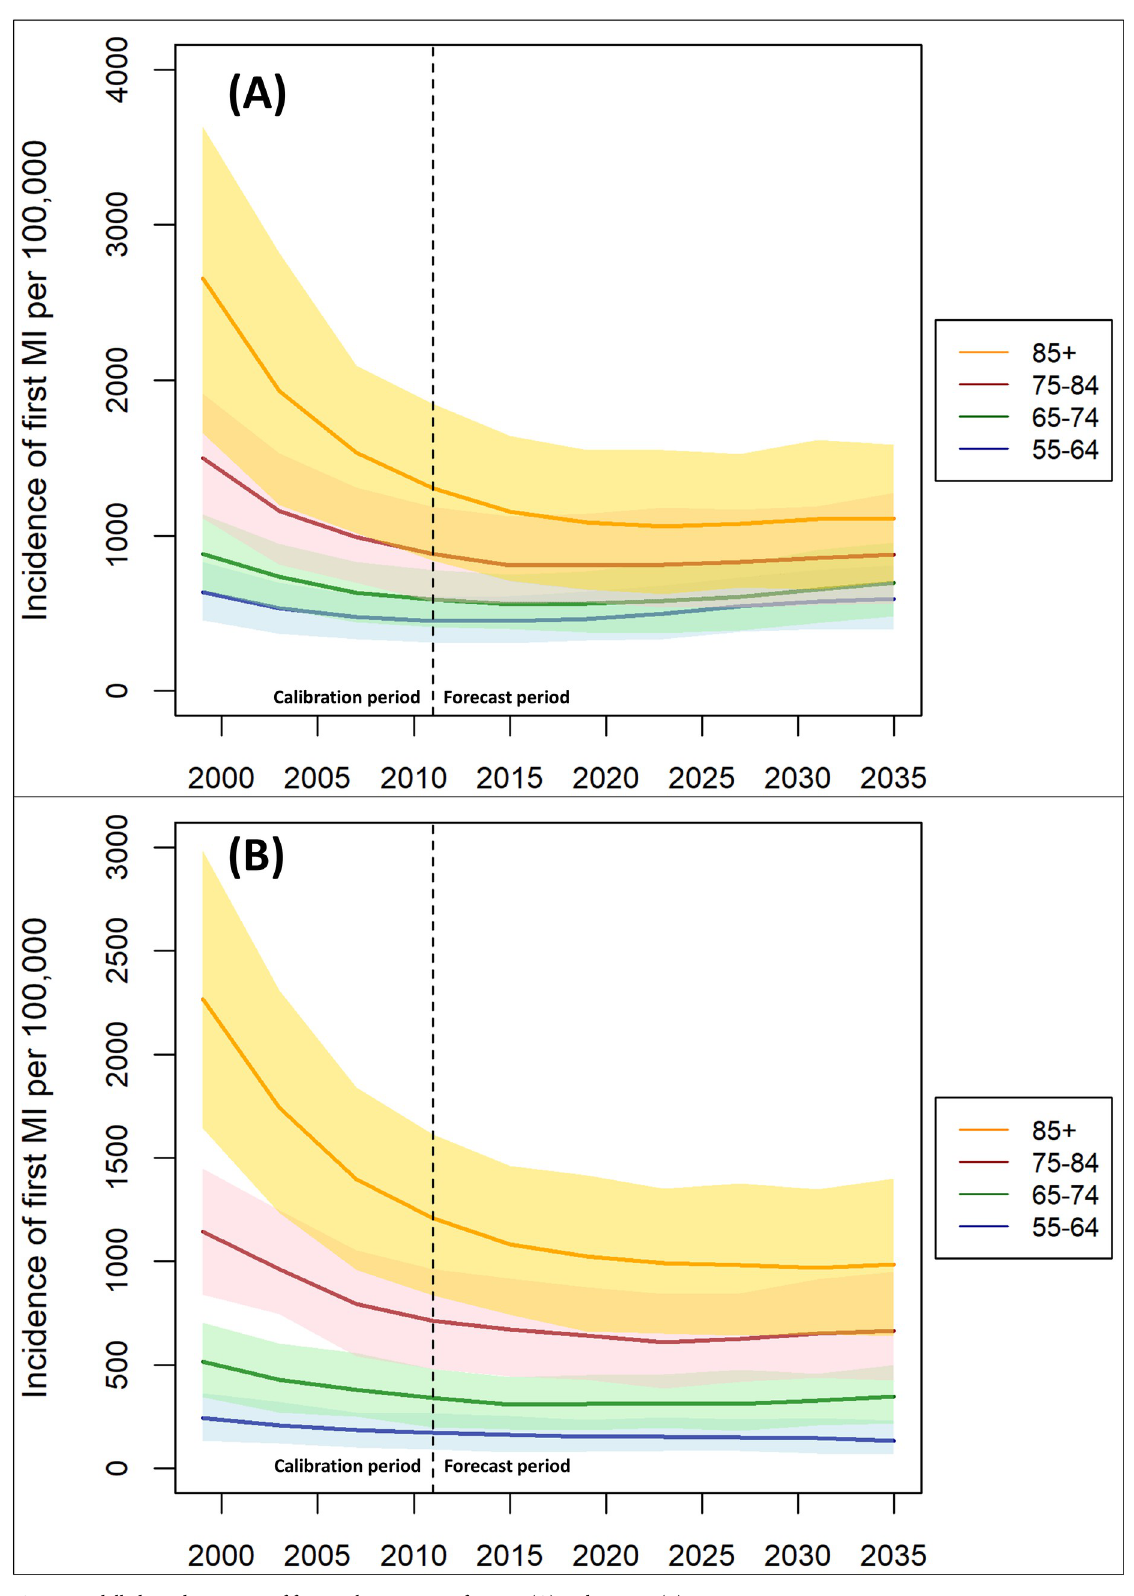
Fig 1. Modelled incidence rates of first MI by age group for men (A) and women (B), 1998–2035. https://doi.org/10.1371/journal.pone.0270189.g001 PLOS ONE | https://doi.org/10.1371/journal.pone.0270189 June 30,